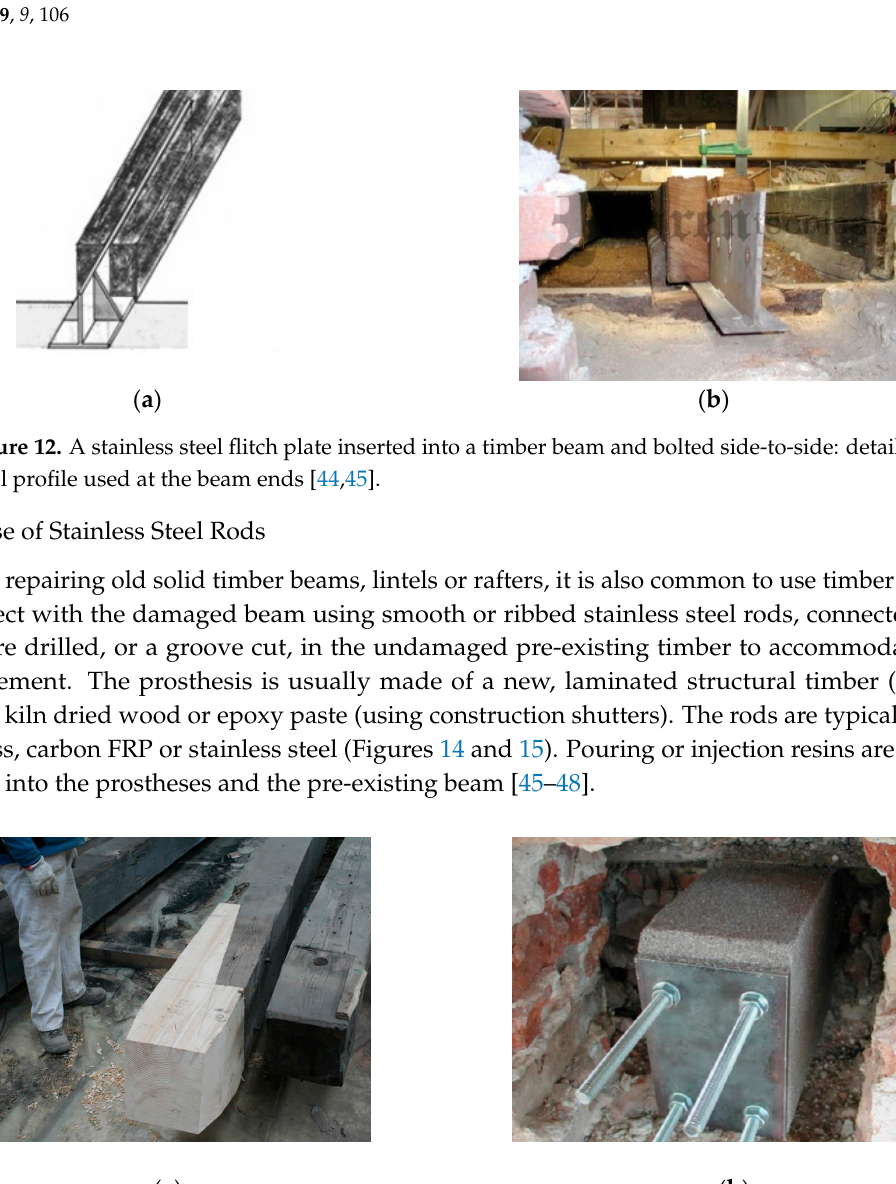
Figure 13. Re-construction of the beam ends: ( a ) stainless steel reinforced wooden prosthesis; ( b ) detail of the stainless steel reinforced epoxy prosthesis [48].